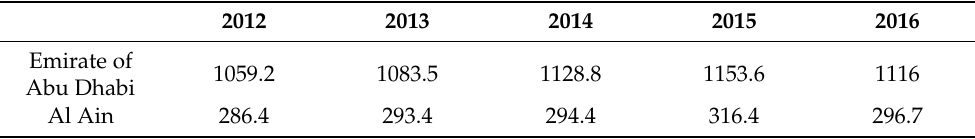
Table 1. Consumption of Desalinated Water in the Region (hm 3 ).